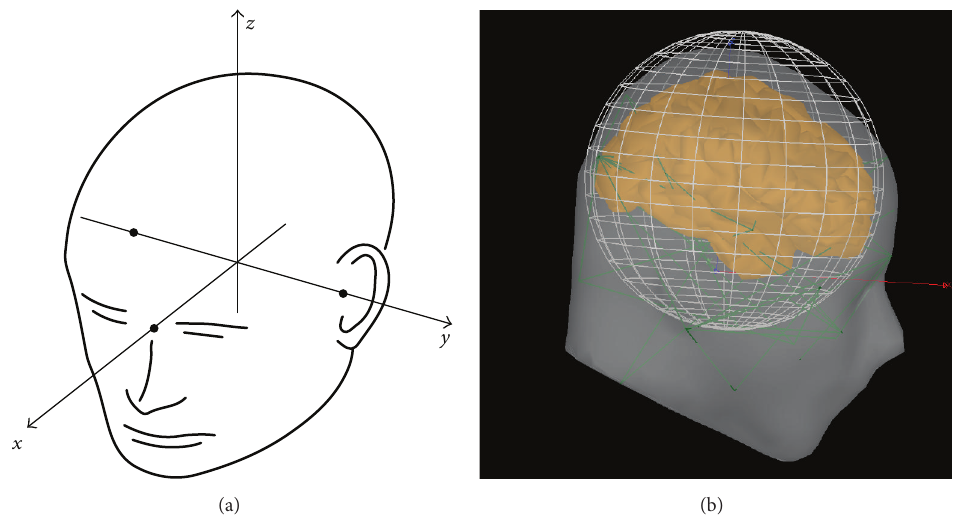
Figure 1: Simulation settings. (a) Coordinate system used in the simulation settings. The 𝑥 -axis of the head coordinate system passes through the two periauricular points with positive direction to the right. The 𝑦 -axis passes through the nasion and is normal to the axis. The 𝑧 -axis points up according to the right-hand rule and is normal to the 𝑥𝑦 plane. (b) Illustration of the head model, where the whole brain was completely encompassed by the